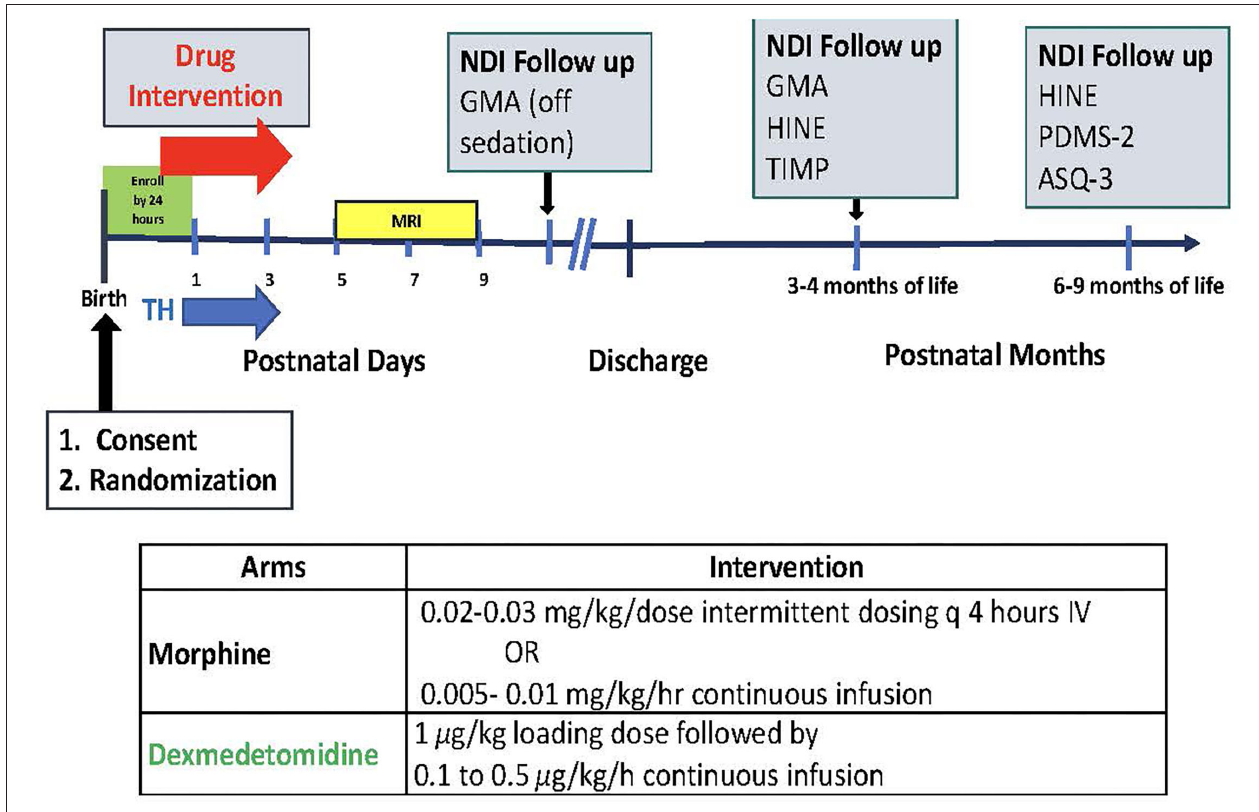
FIGURE 1 | Study timeline and interventions. TH, brain MRI, neurodevelopmental impairment (NDI) follow up with GMA (Generalized Movement Assessment); HINE (Hammersmith Infant Neurological Exam); TIMP (Test of Infant Motor Performance); PDMS-2 (Peabody Developmental Motor Skills); ASQ-3 (The Ages and Stages